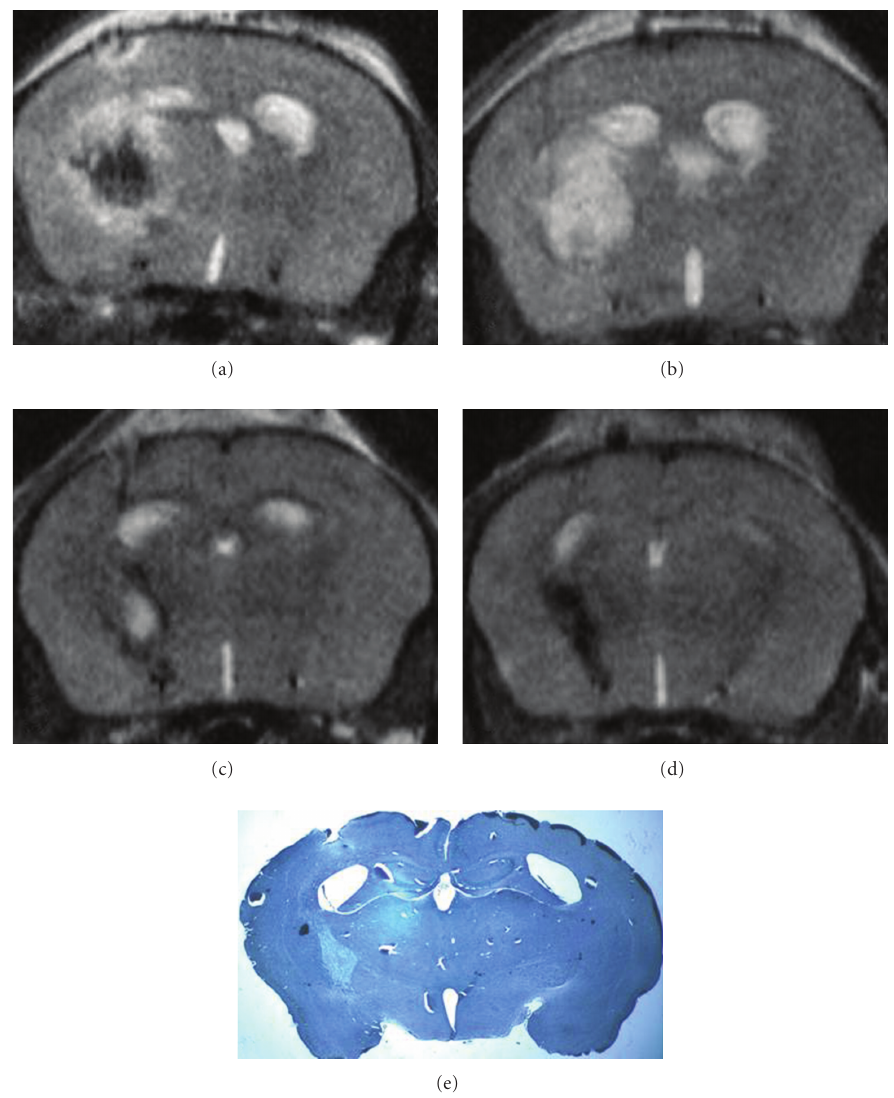
Figure 4: T2-weighted RARE spin-echo images at 24 hours (a) show predominantly low-signal hematoma within the left caudate/putamen, consistent with deoxyhemoglobin and intracellular methemoglobin. At 72 hours (b), there is conversion to predominantly high-signal, consistent with extracellular methemoglobin. In the course of hematoma resorption, the core hyperintensity (c) subsequently transforms to a hypointense gliotic scar at 21 days (d). The cryostat section stained with Luxol Fast Blue and cresyl violet [ × 10] (e) also well delineates the gliotic